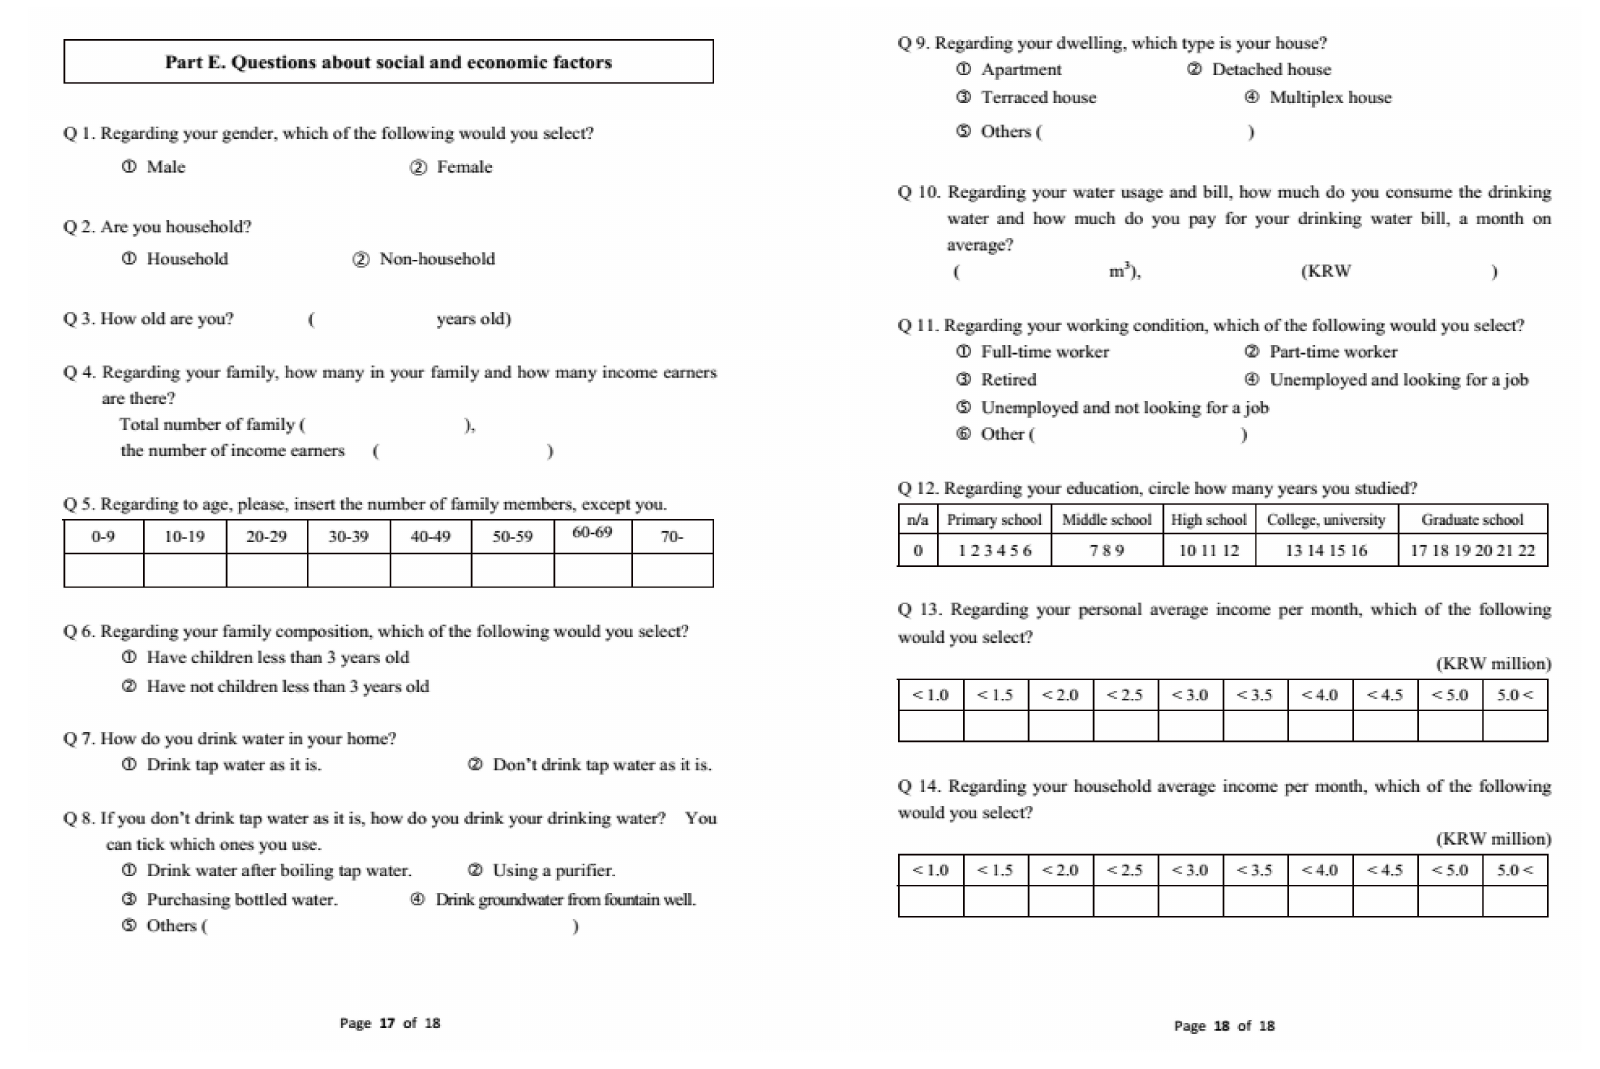
Figure A1. A sample of the